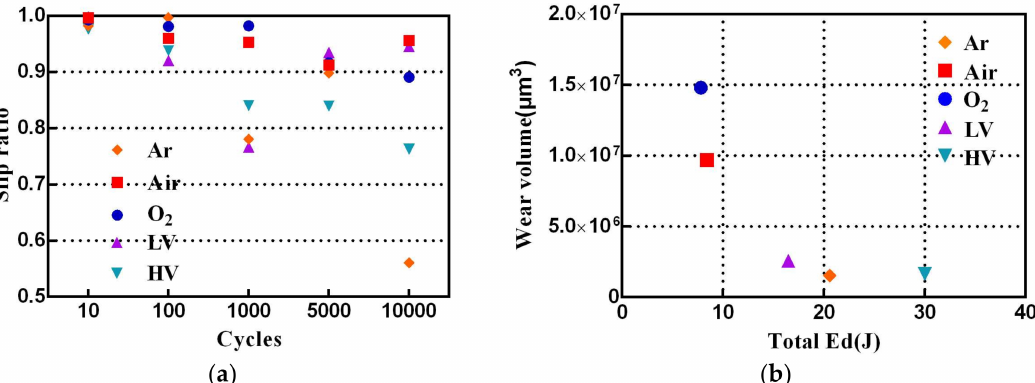
Figure 5. Evolution of slip ratio with cycle number ( a ) and Ed versus wear volume under different atmosphere and vacuum conditions ( b